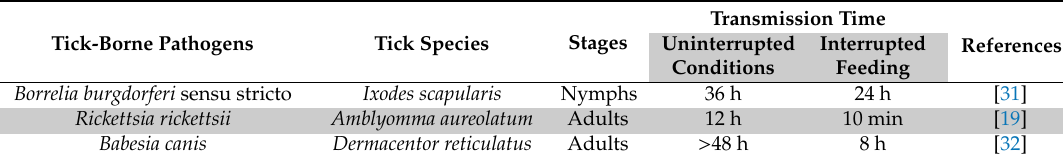
Table 1. Transmission times for selected tick-borne pathogens under uninterrupted and interrupted tick feeding